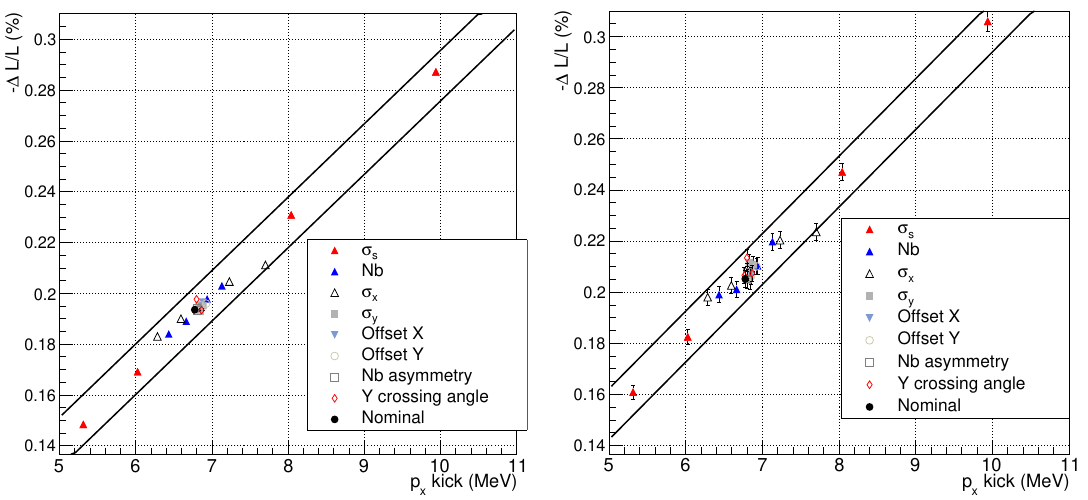
Figure 10 . Luminosity bias as a function of the (absolute value of the) event kick (i.e. twice the k of section 3.2), for (left) leading-order Bhabha events and (right) from BHWIDE events, determined for several variations of the beam parameters. The two lines indicate a (cid:6) 10 (cid:0) 4 variation around a linear (cid:12)t to all